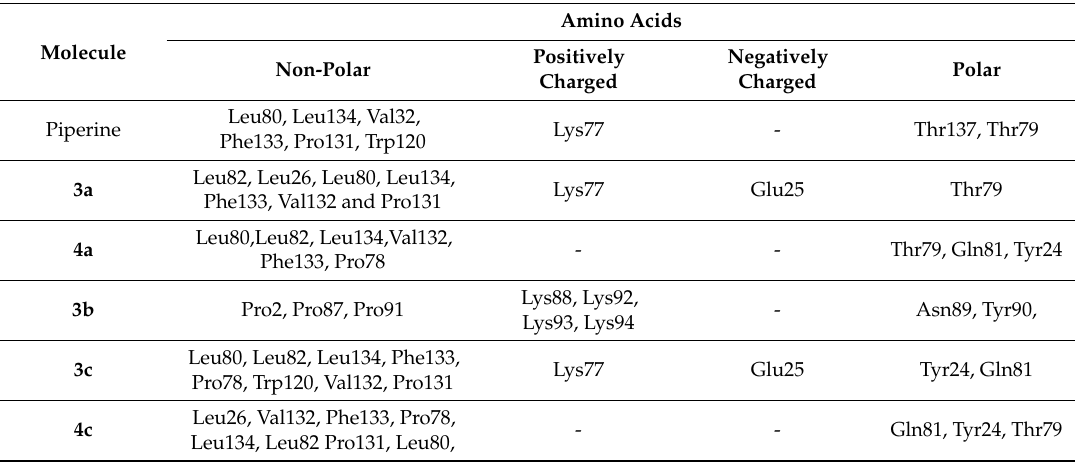
Figure 3. IL-1 β binding microenvironments details for piperine and PPL analogues visualized with LigPlot. Table 1. Amino acids that compose the microenvironment of the complex IL-1 β / piperine and PPL analogues, obtained by molecular